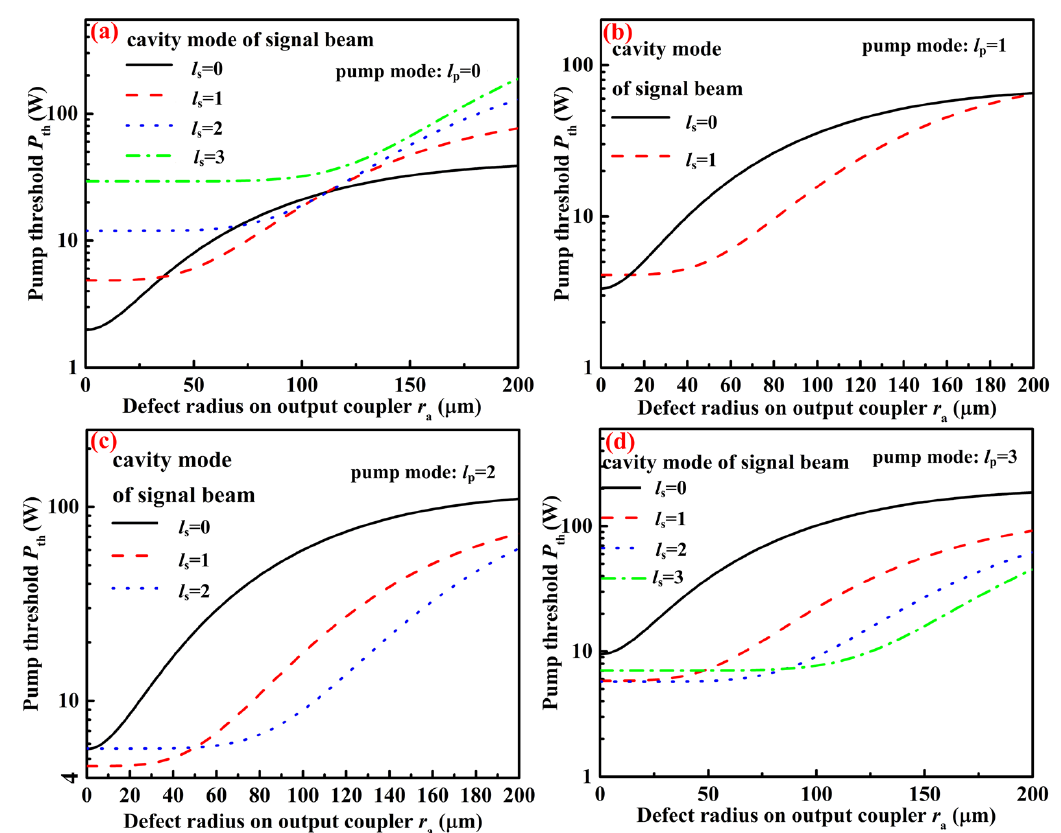
Figure 6. Theoretical predictions for the threshold of SPP-SRO versus the defect radius on output coupler r a for different combinations of pump vortex order l p and resonant signal vortex order l s . Here w p = 63 μm, m = 0.686. The beam radius of the signal wave on the output coupler is W s = 174 μm. ( a ). l p = 0; ( b ). l p = 1; ( c ). l p = 2; ( d ). l p = 3.